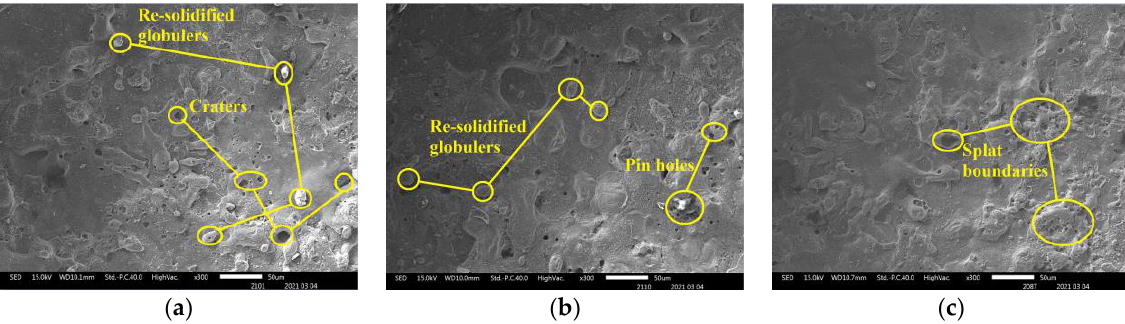
Figure 13. The surface of SS304 alloy machined by different electrodes: ( a ) W90Cu10; ( b ) W80Cu20; ( c ) W70Cu30.